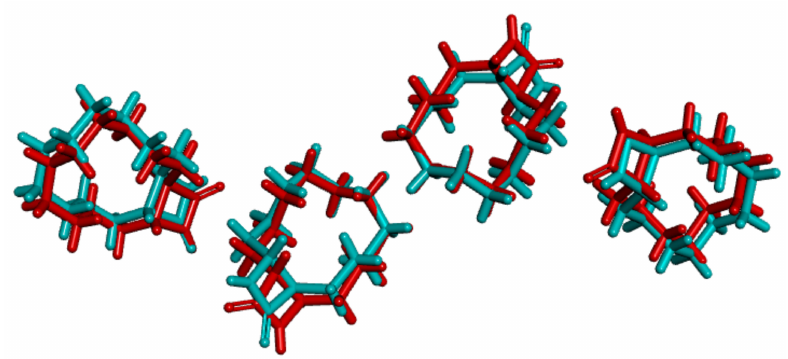
Figure 2. Conformational overlays of β -lactam unit cells, where the red and blue molecules represent forms I and II, respectively, with a root-mean-square deviation (RMSD) of 3.7891 Å.